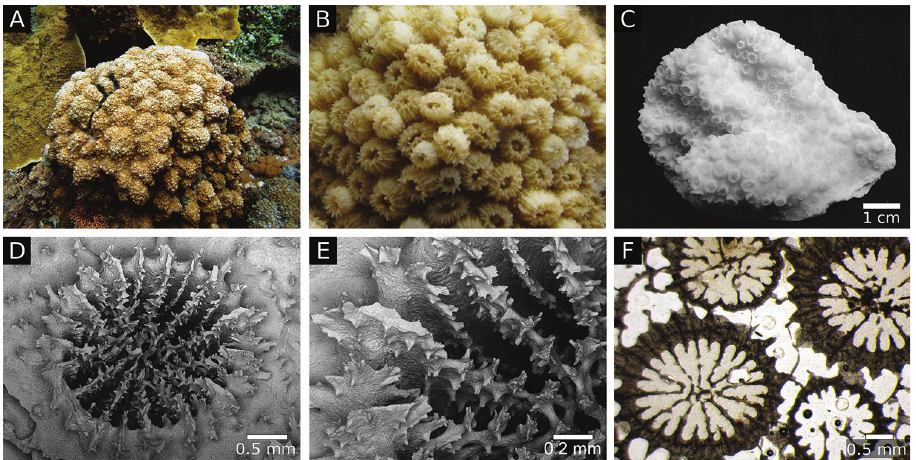
Figure 1. Cyphastrea salae sp. n. A habit photo of the holotype (G.18222) in situ B close up of holotype in situ C holotype D SEM of corallite E SEM of septa F transverse thin Table 1. Summary statistics of morphological variables for Cyphastrea salae (n = 55) and C. microph- thalma (n = 40). Measurements in mm.